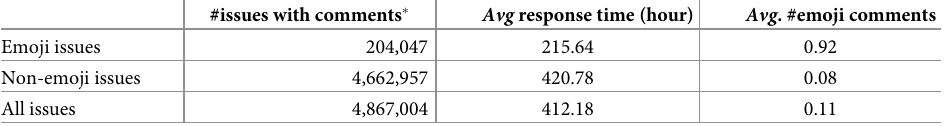
Table 4. Difference of responses between issues with and without emoji. For issues with at least one comment, the time to receive the first comment for emoji issues is significantly shorter than non-emoji issues ( p < 0.001, Welch two- sample t-test). Emoji issues get significantly more comments containing at least one emoji ( p < 0.001, Welch two-sam- ple